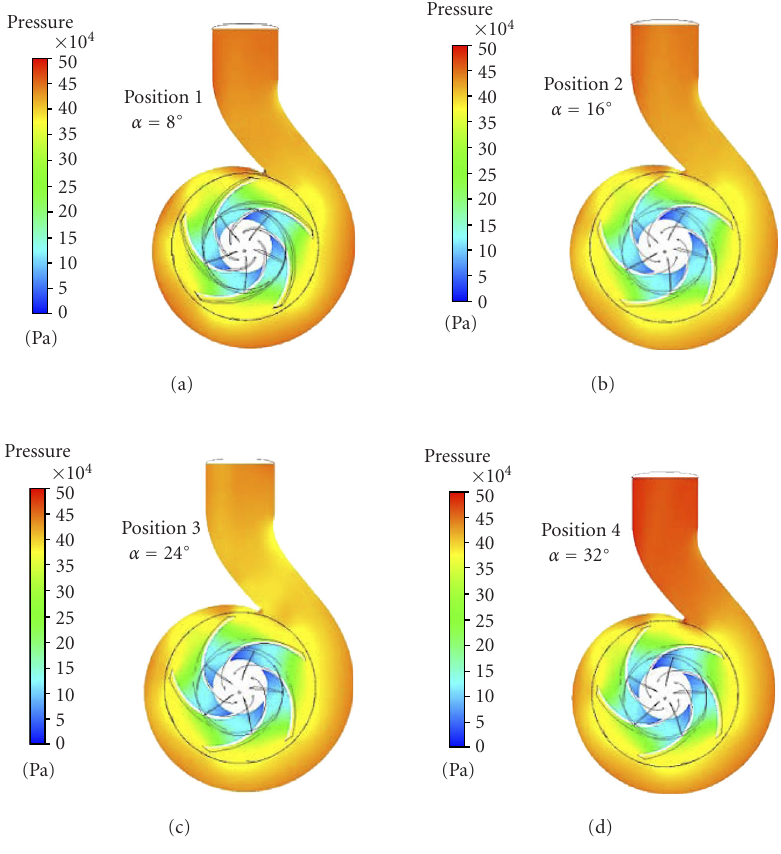
Figure 15: Static pressure field of pump NS32 at the best e ffi ciency point ( Q/Q bep = 1) for di ff erent relative positions of impeller-volute